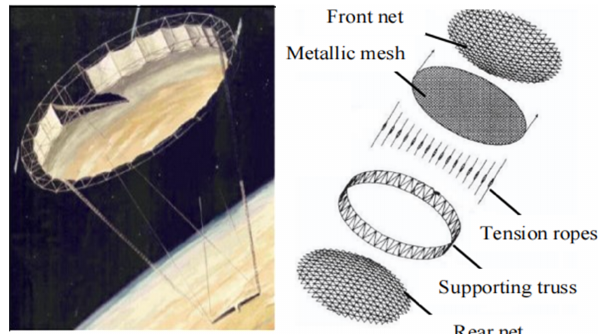
Figure 1. Mechanism diagram of the RTDAM.